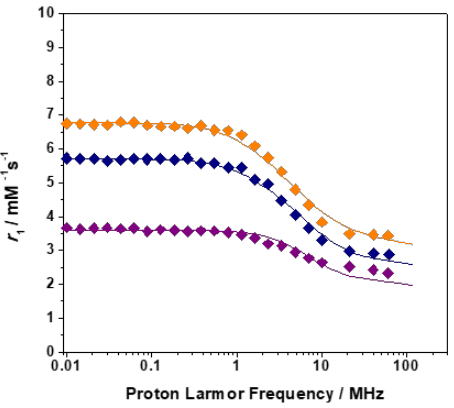
Figure 4. 1 H NMRD profiles of at 298 K of GdL1 (blue, 2.4 mM), GdL2 (orange, 2.5 mM) and GdL3 (purple, 4.4 mM). The solid lines were calculated with the parameters reported in Table 1.